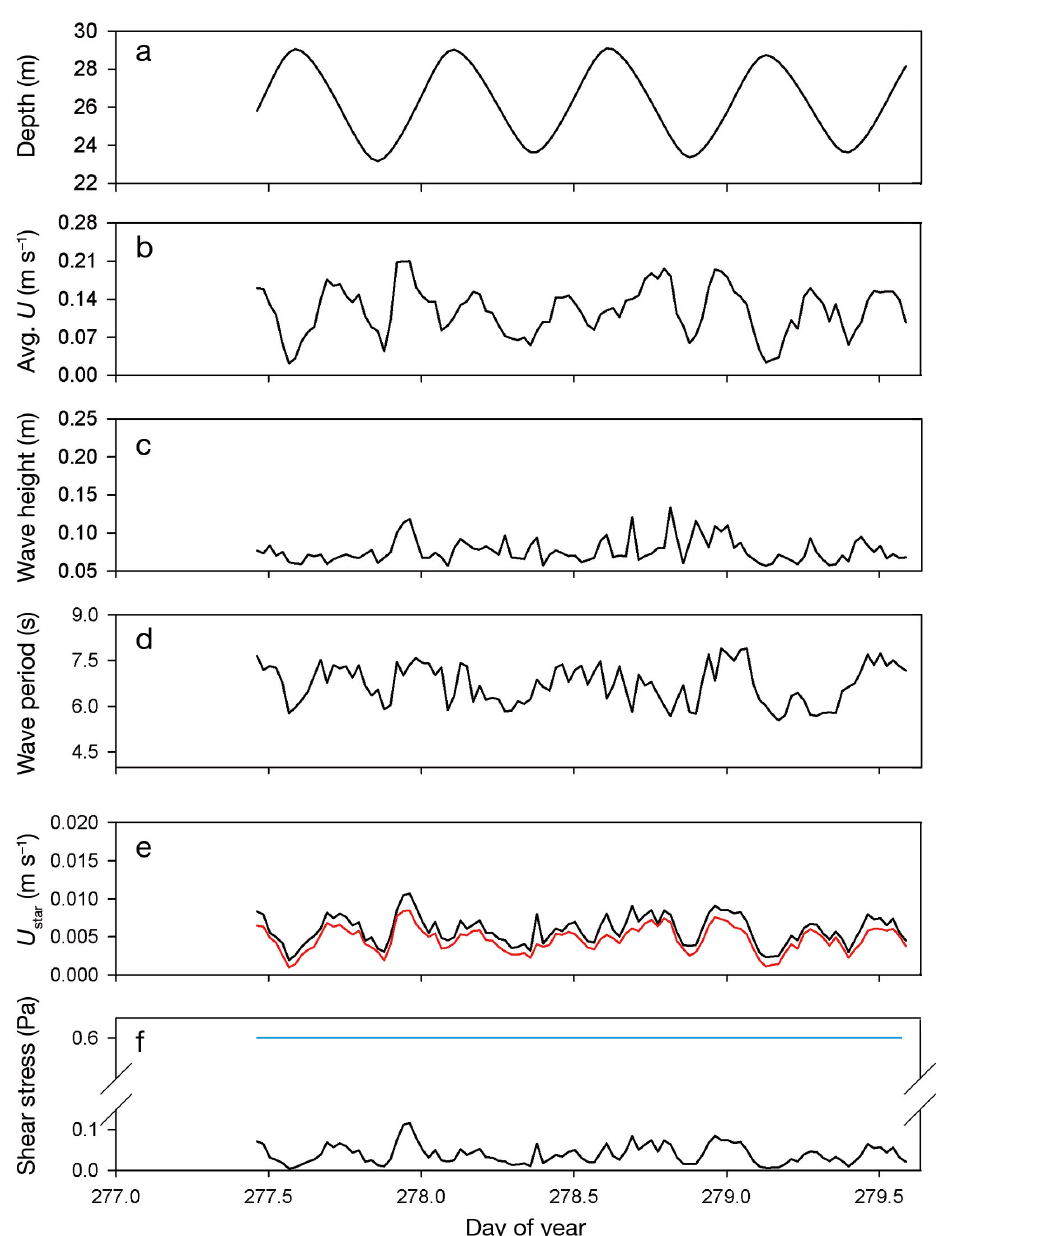
Fig. 3. Navy Island physical oceanography data from October 2016 from near cage. (a) Change in water depth from the CTD; (b) average current speed ( U) ; (c) significant wave height; (d) wave period; (e) calculated combined wave current shear veloc- ity ( U star ) (black) and current only shear velocity (red); (f) calculated shear stress (black) and the maximum shear stress of the Gust chamber erosion experiments stress at both study locations had similar values for the other study time periods compared with the last 2016 sampling. Significant wave heights at Navy Island are very small compared to Jordan Bay, rang-